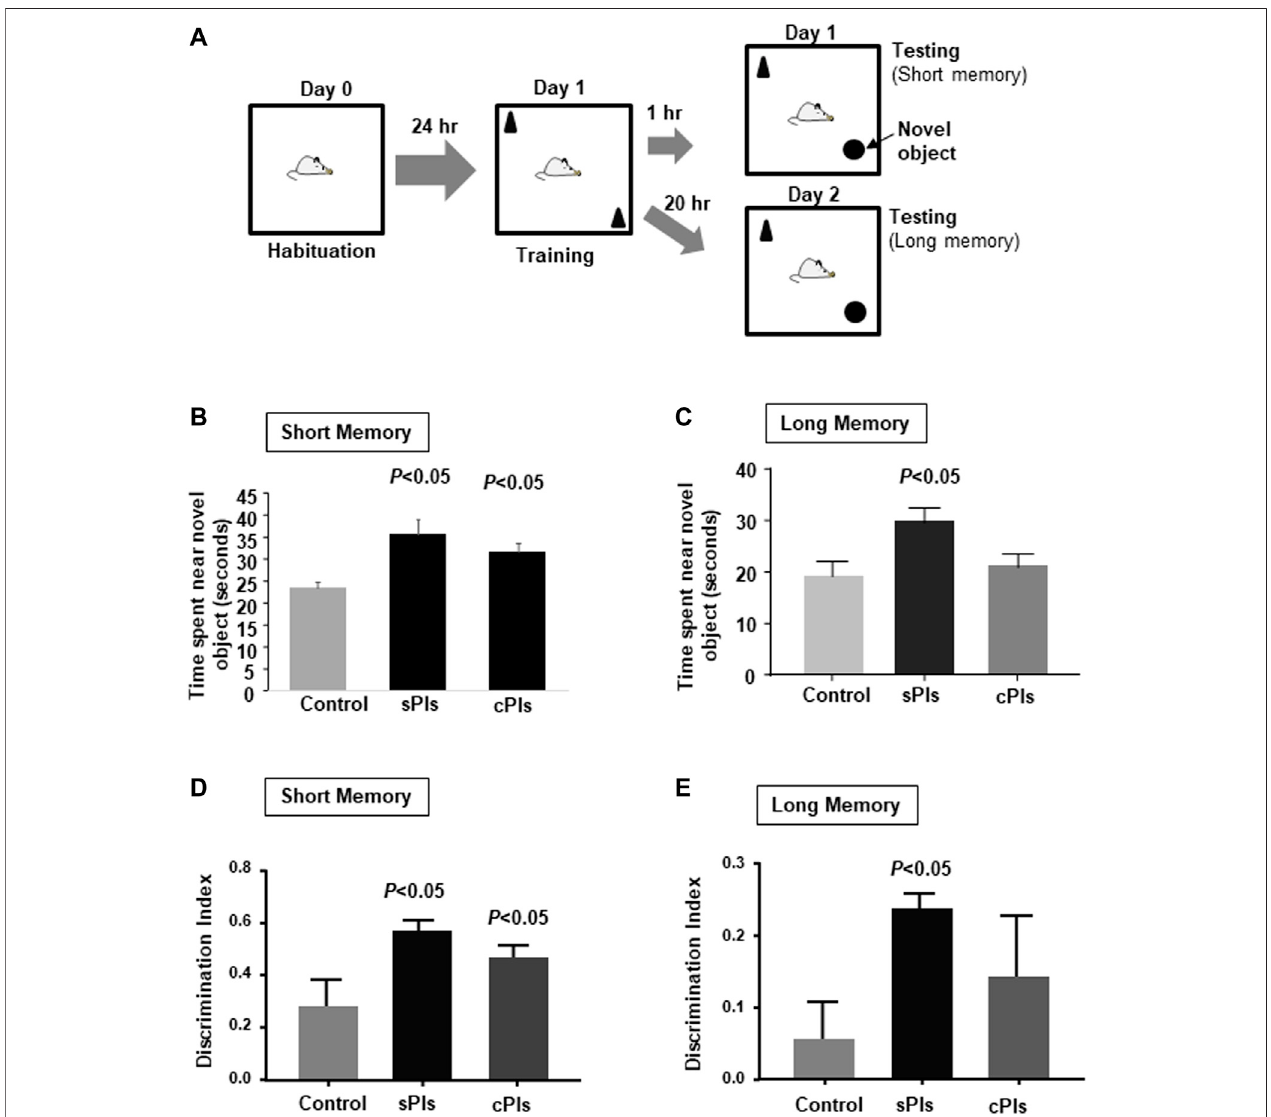
FIGURE 9 | Memory enhancing effects of plasmalogens derived from scallop and chicken. (A) Diagram of the novel object recognition test. The mice were subjected to the cPls (Pls from chicken) and sPls (Pls from scallop) drinking (0.01% w/v) for 6 weeks before the tests. (B) The data show the time spent near the novel platform when the mice were placed in the chamber after 1 h of the testing phase. (C) The data show the average time spent near the novel platform when mice were subjectedtothetestingphaseof18 hfollowingthetrainingphase. (D) Thedatashowthediscriminationindexintheshort-termmemory. (E) Discriminationindexof thelong-termmemory.Eachexperimentalgroupcontained fi vemice( n =5).The p valueswerecalculatedbyANOVAfollowedbyBonferroni ’ sposthocteststocompare the multiple groups.